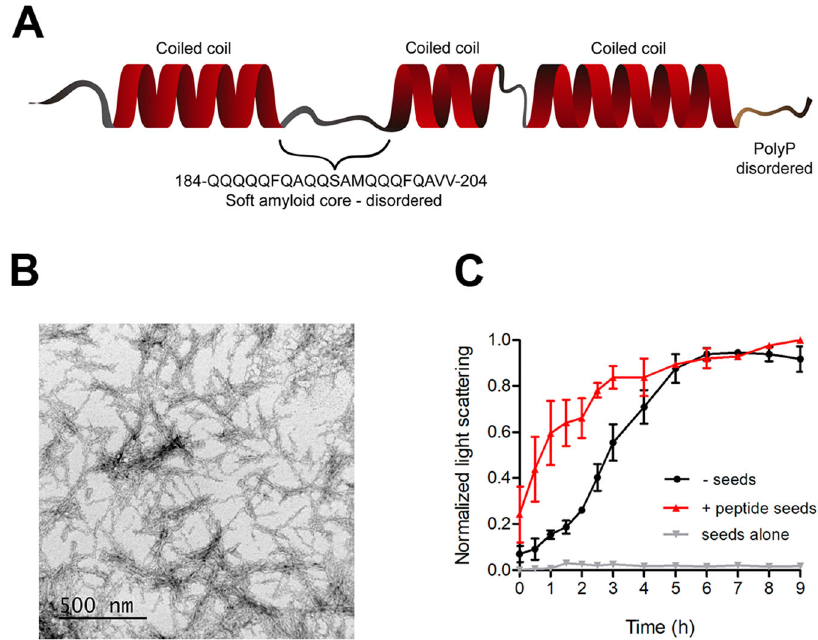
Fig. 8 MED15 soft amyloid core seeds MED15-PrLD aggregation. A Schematic diagram of MED15-PrLD structure. It consists of three coiled-coil regions predicted by COILS 33 (14-residue window) separated by disordered regions. The disorder region between the fi rst and second coiled-coil corresponds to the soft amyloid core (SAC) predicted by pWaltz 73 . The fi nal disordered region corresponds to the Pro residues fl anking the polyQ tracts (polyP disordered). B Transmission electron microscopy image of aggregated 100 μ M MED15CC SAC in 20 mM Tris pH 7.5 and 150 mM NaCl. C Light scattering kinetics of 5 μ M GFP-MED15CC incubated at 37 °C in the absence or presence of 2% MED15 SAC seeds (peptide seeds). Kinetics of seeds alone is shown as control. Aggregation was performed in 20 mM Tris pH 7.5 and 150 mM